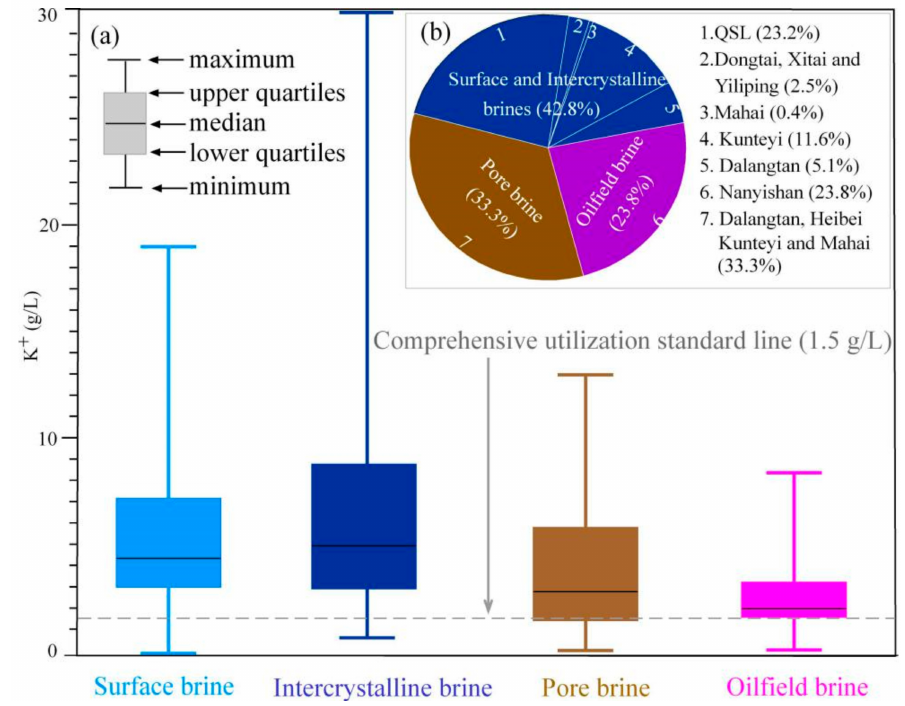
Figure 3. ( a ) Box-plot showing the K + concentrations of surface, intercrystalline, pore, and oilfield brines in the QB (the comprehensive utilization data from [22]); ( b ) the reserves of surface and intercrystalline brines, and pore and oilfield brines in the QB (the reserve data from [10]). Here, sixty-four intercrystalline brines from the Qarhan Salt Lake (QSL) were collected and + analyzed for the K concentrations. Combining those results with the major ionic compositions of + 102 river waters, 12 pore brines, and 54 oilfield brines, and the K concentrations of 13 surface brines and 42 intercrystalline brines from di ff erent salt lakes in the QB, this study aimed to (i) identify the fluxes and sources of K in the brines, and (ii) elucidate the distribution and sedimentary pattern